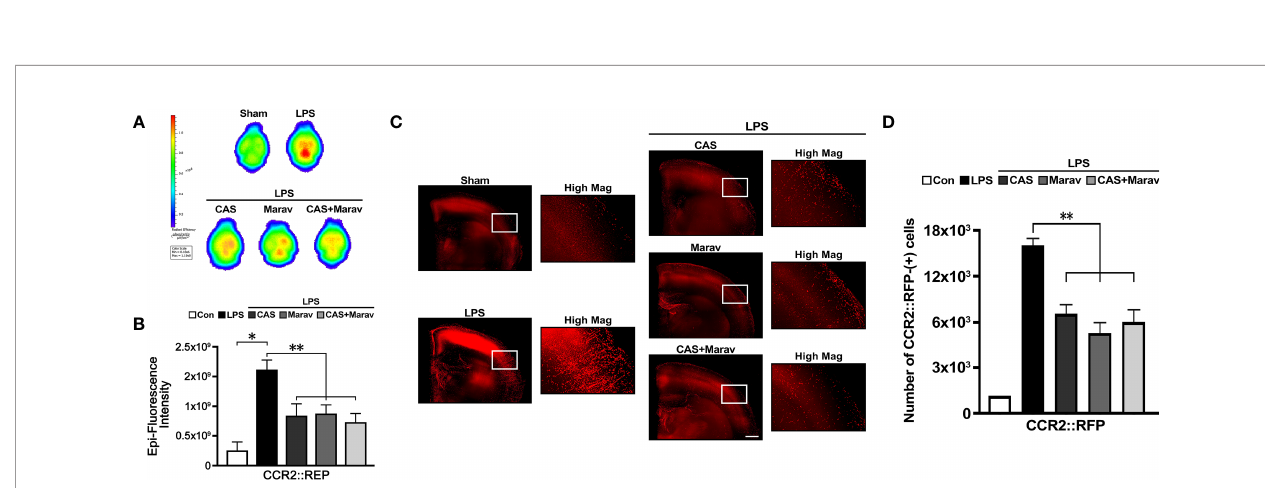
FIGURE 5 | CCR2::RFP cell migration in neuroin fl ammation condition. (A) IVIS spectrum showing the ex vivo brain image with RFP after LPS injection. (B) The fl uorescence intensity CCR2::RFP cells is lower in the CAS, Marav, and CAS+Marav groups than in the nontreatment group. (C) CLARITY images and also show a lower intensity of CCR2::RFP cells in the CAS, Marav, and CAS+Marav groups than in the nontreatment group. High magni fi cation images (Hig Mag) also showed the same the condition. (D) Graphs showing the number of CCR2::RFP-positive cells are decreased in the CAS, Marav, and CAS+Marav groups (sham clarity group, n=1; Experimental CLARITY group, n=3; IVIS group, n=3; *P<0.01, **P<0.05, scale bar=500